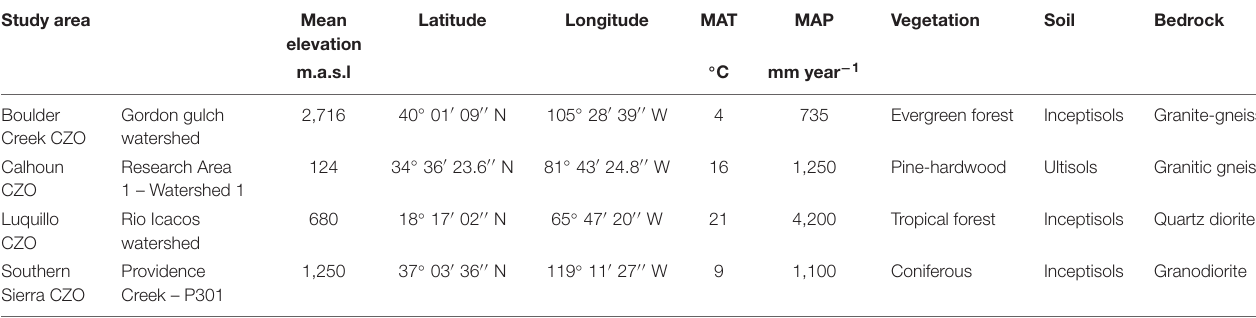
TABLE 1 | Climate, ecosystem, and geologic properties of sampling sites for the four Critical Zone Observatories (CZO). Study